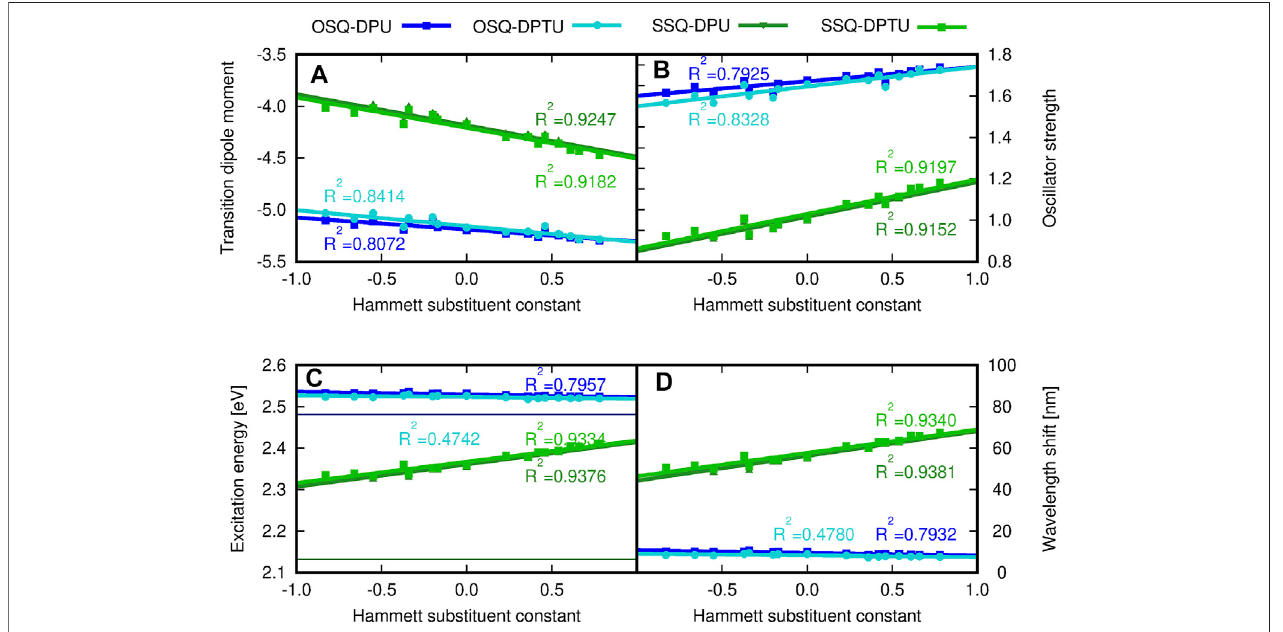
FIGURE 13 | (A) Transition dipole moment component, (B) oscillator strengths, (C) excitation energy (eV), and (D) maximum wavelength shift (nm) with respect to the isolated oxo- or thiosquaraine spectrum, respectively, for one-photon absorption in the investigated complexes versus the Hammett substituent constant for substituents in N,N ′ -diphenyl(thio)urea estimated within the CAM-B3LYP/6-31+G(d) approach. The reference excitation energy for isolated squaraines is shown for comparison in panel (C) as a thin navy horizontal line for oxosquaraine and thin dark green horizontal line for thiosquaraine.